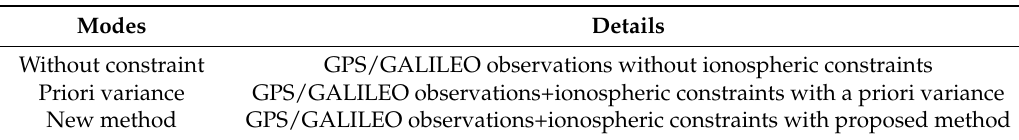
Table 1. List of Data Processing Methods.